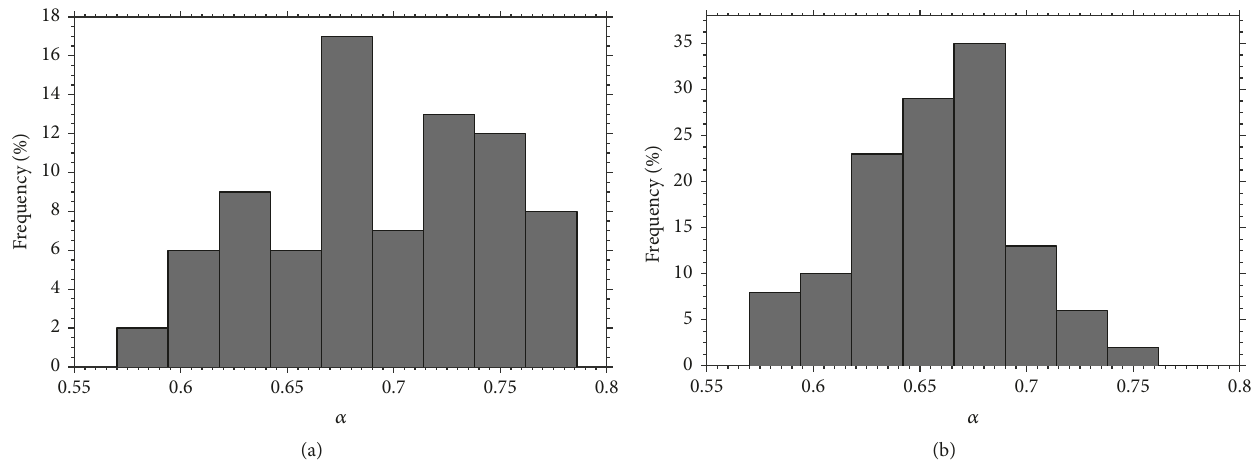
Figure 6: The frequency distribution of the scaling exponents of OLR over TP (a) and IMR